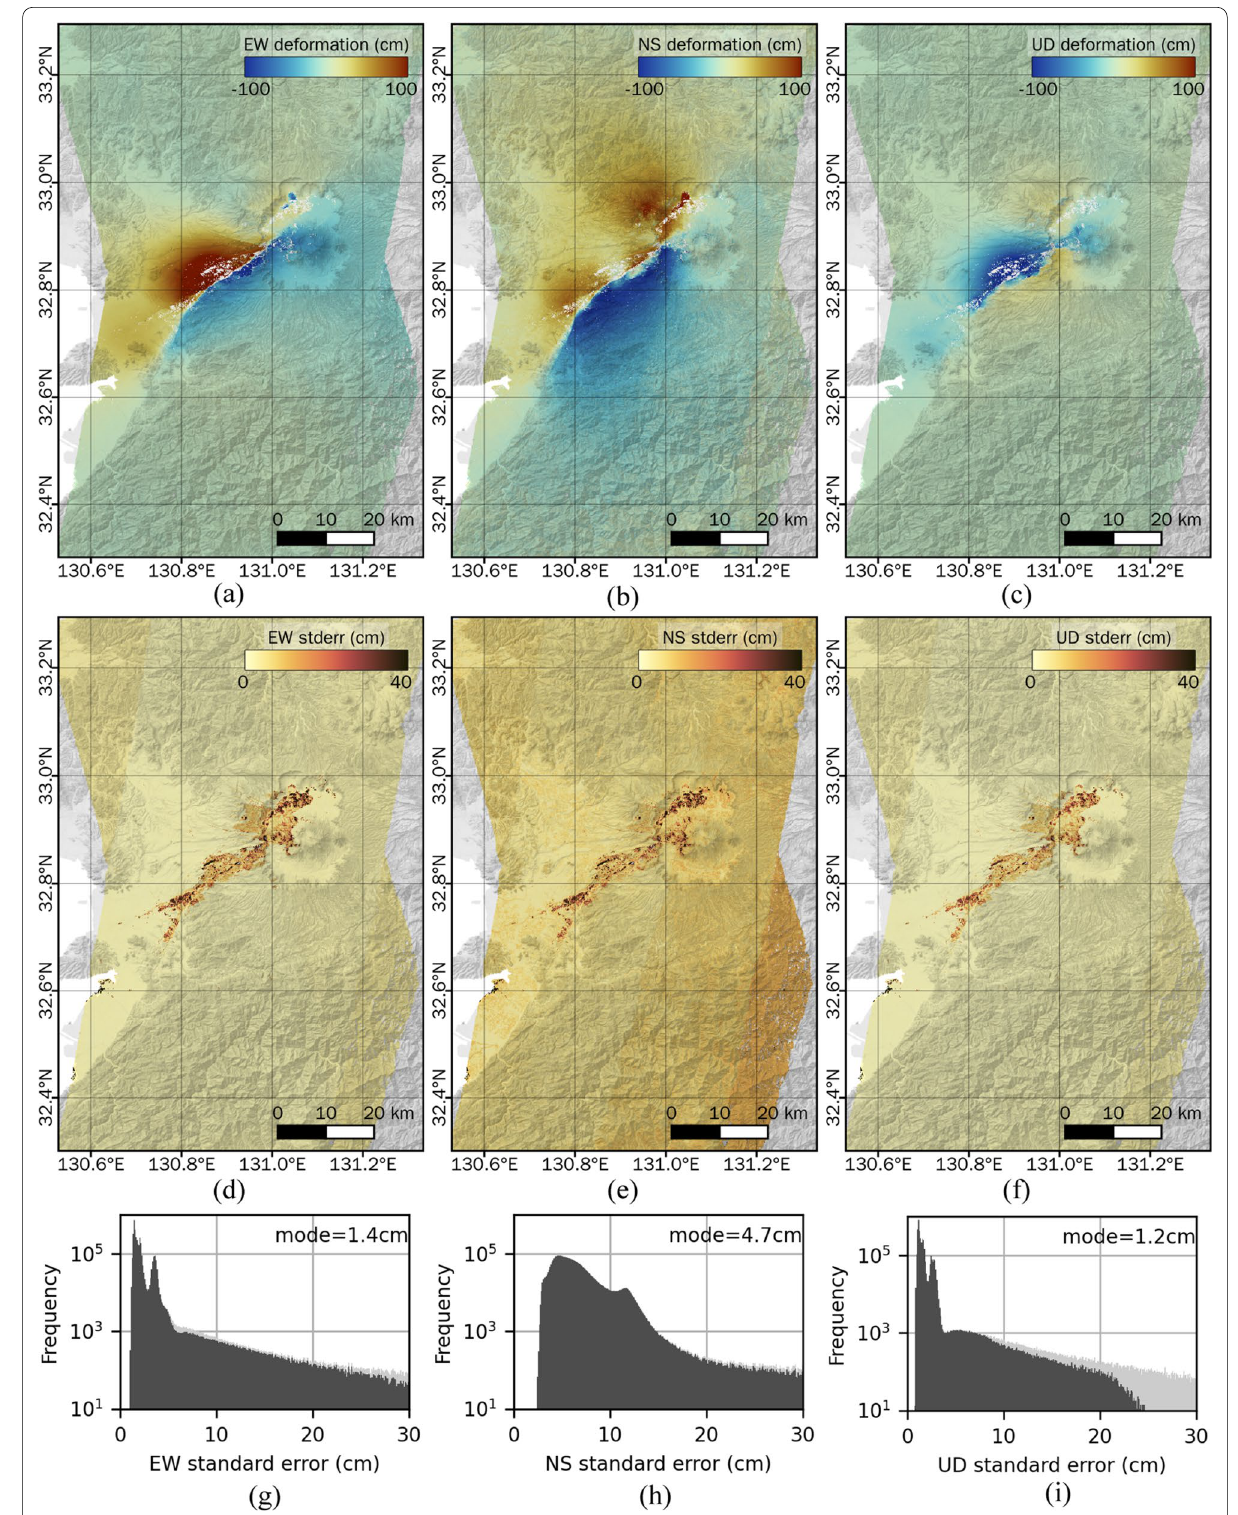
Fig. 3 a – c 3D (i.e., EW, NS, and UD, respectively) deformation decomposed from the integration of InSAR, SBI, and pixel offset data masked based on noise metrics in Kumamoto. d – f The estimated standard errors of the 3D components. g – i Histograms of the standard errors of the 3D components. The light-gray parts denote frequency including the masked